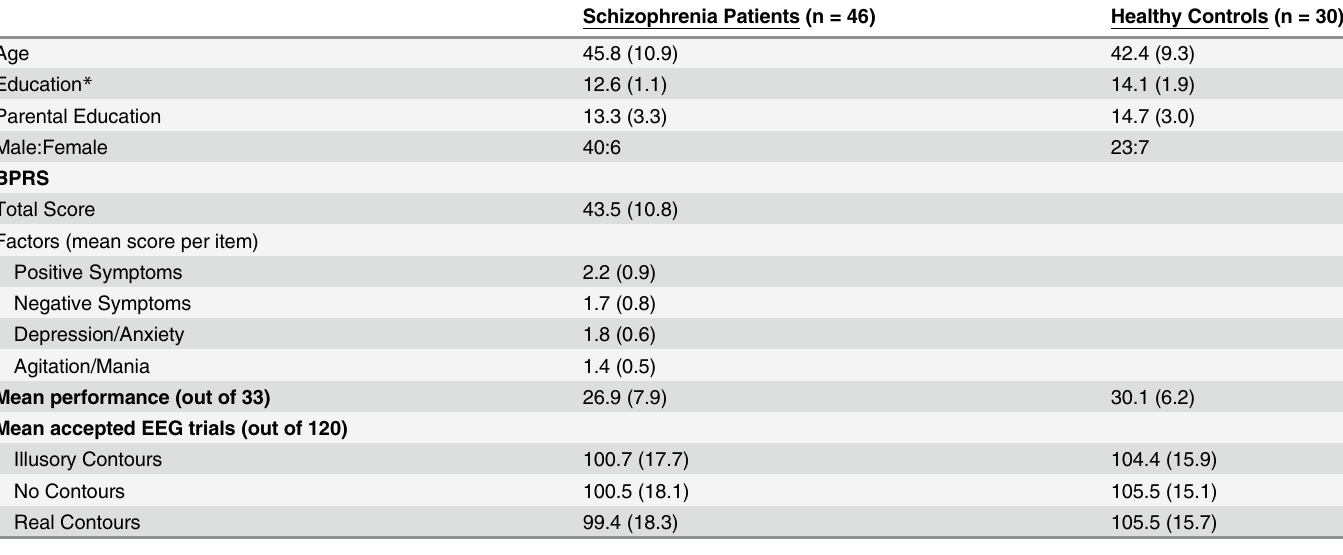
Table 1. Mean (SD) demographic information, symptom ratings, behavioral performance, and accepted EEG trials. Schizophrenia Patients (n =